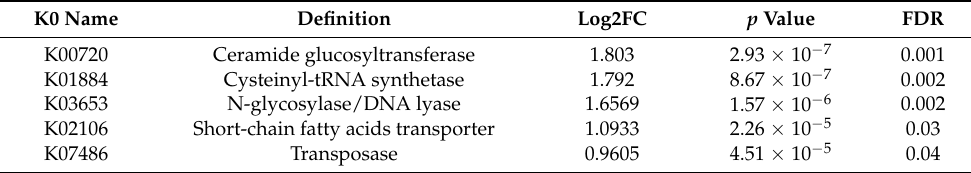
Table 4. Metabolic activity differences between the tertiles with lower and higher adherence to MD by Tax4Fun